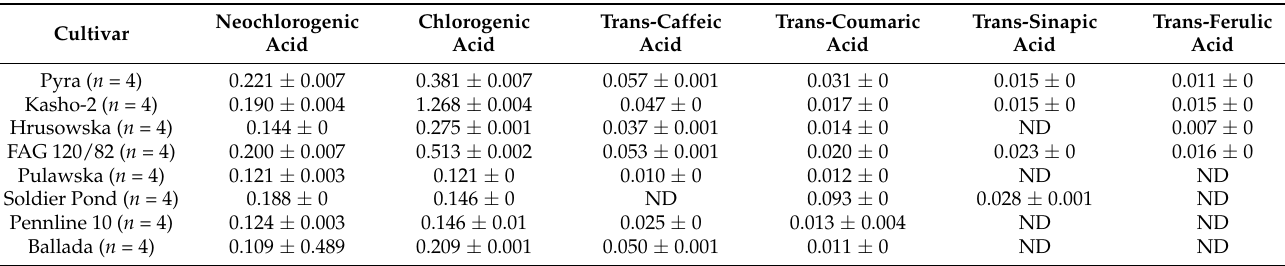
Table 3. Content of phenolic acids in flowers of investigated buckwheat cultivars (mg/g d.w., means ± standard deviations of four independent